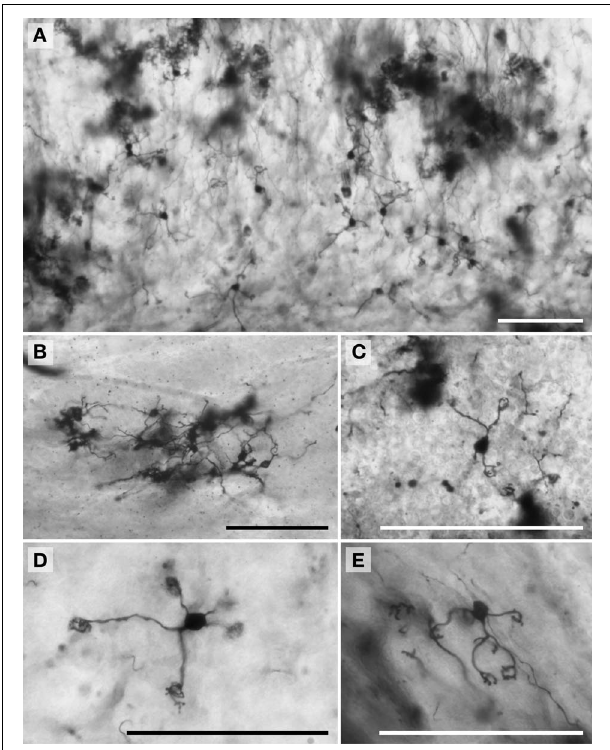
FIGURE 7 | Photomicrographs of Golgi-stained granule neurons. (A) Siberian tiger; (B) humpback whale; (C) chimpanzee; (D) Siberian tiger; and (E) giraffe. Scale bars: 100 μ